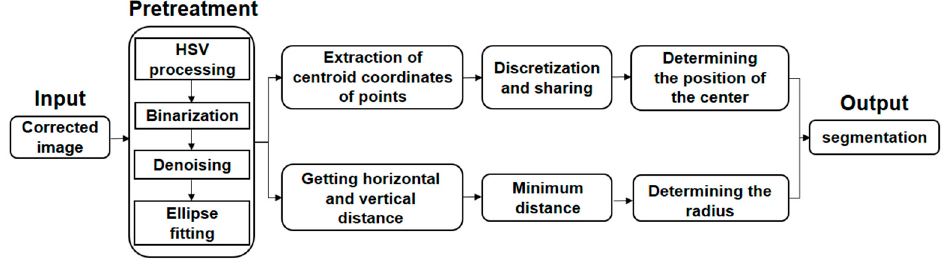
Figure 7. Algorithm flowchart.